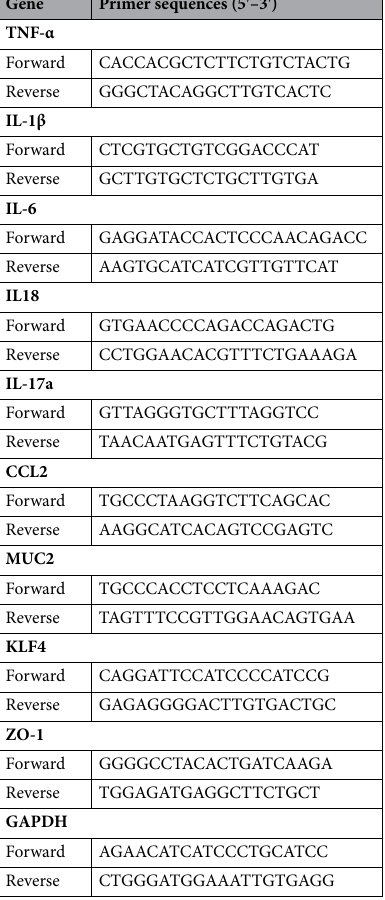
Table 2. Primers used in the real‑time PCR